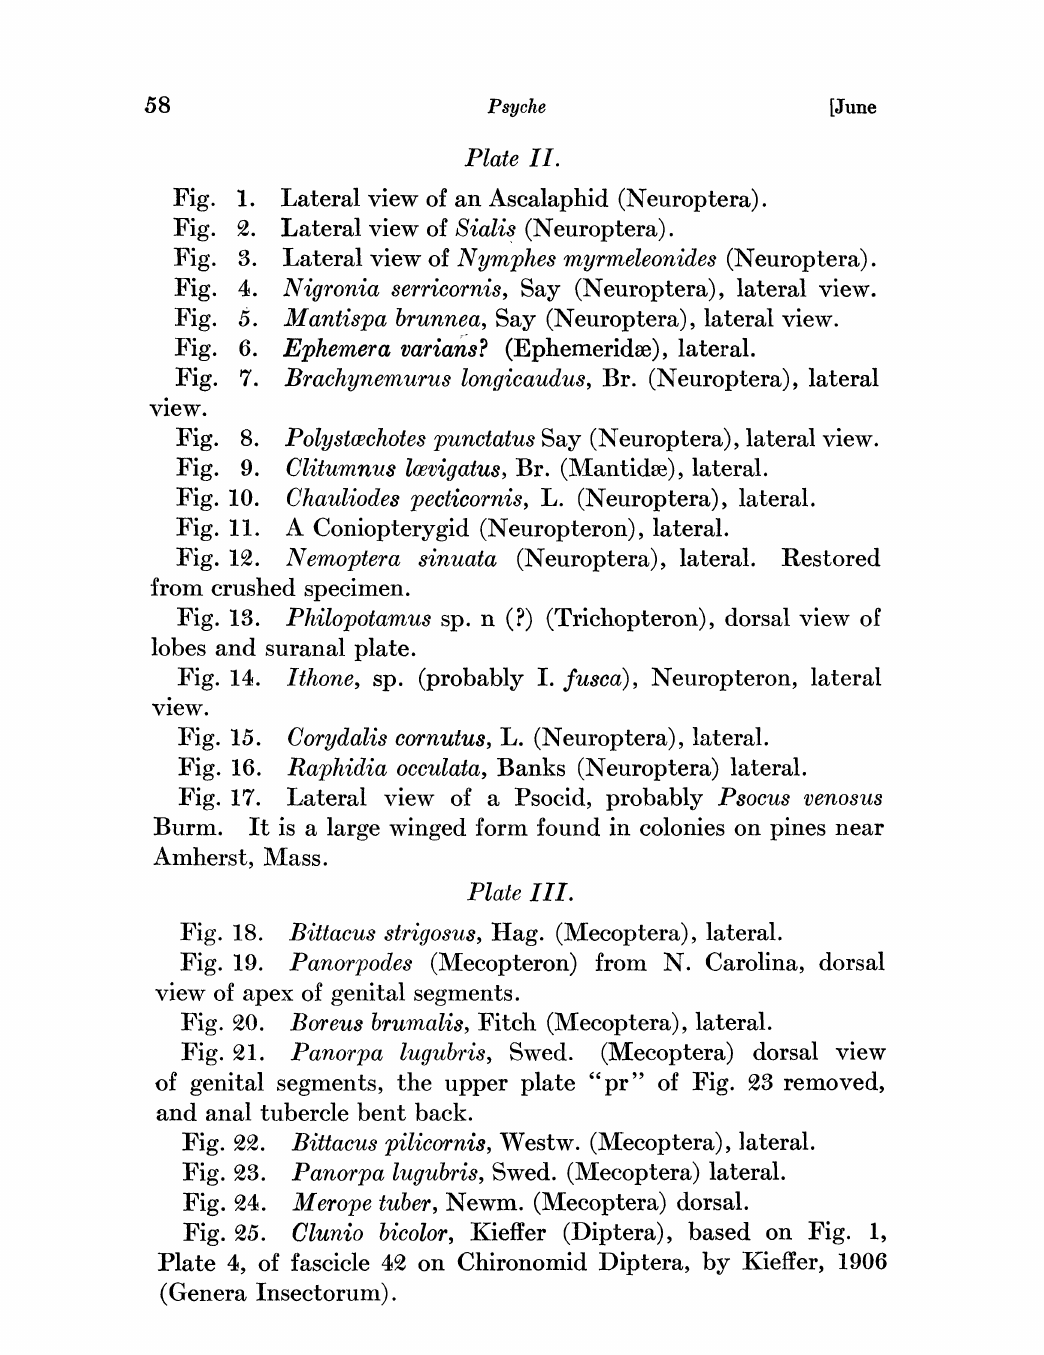
Fig. 11. Fig. 1. from crushed specimen. Fig. 18. Philopotamus sp. n (?) (Trichopteron), dorsal view of lobes and suranal plate. Fig. 14. Ithone, sp. (probably I. fusca), Neuropteron, lateral Fig. 15. Corydalis cornutus, L. (Neuroptera), lateral. Fig. 16. Raphidia occulata, Banks (Neuroptera) lateral. Fig. 17. Lateral view of a 1)socid, probably Psocus venosus Burm. It is a large winged form found in colonies on pines near Amherst, Mass. Plate III. Fig. 18. Bittacus strigosus, Hag. (Mecoptera), lateral. Fig. 19. Panorpodes (Mecopteron) from N. Carolina, dorsal view of apex of genital segments. Fig. 0. Boreus brumalis, Fitch (Mecoptera), lateral. Fig. 1. Panorpa lugub’is, Swed. (M:ecoptera) dorsal view . of genital segments, the upper plate "pr" of :Fig. 3 removed, and anal tubercle bent back. ’ig. Bittacus pilicornis, Westw. (M:ecoptera), lateral. :Fig. 3. Panorpa lugubris, Swed. (Mecoptera) lateral. Fig. 4. Merope tuber, Newm. (Mecoptera) dorsal. Fig. 5. Clunio bicolor, Kieffer (Diptera), based on Fig. 1, :Plate 4, of fascicle 4 on Chironomid Diptera, by Kieffer, 1906 (Genera